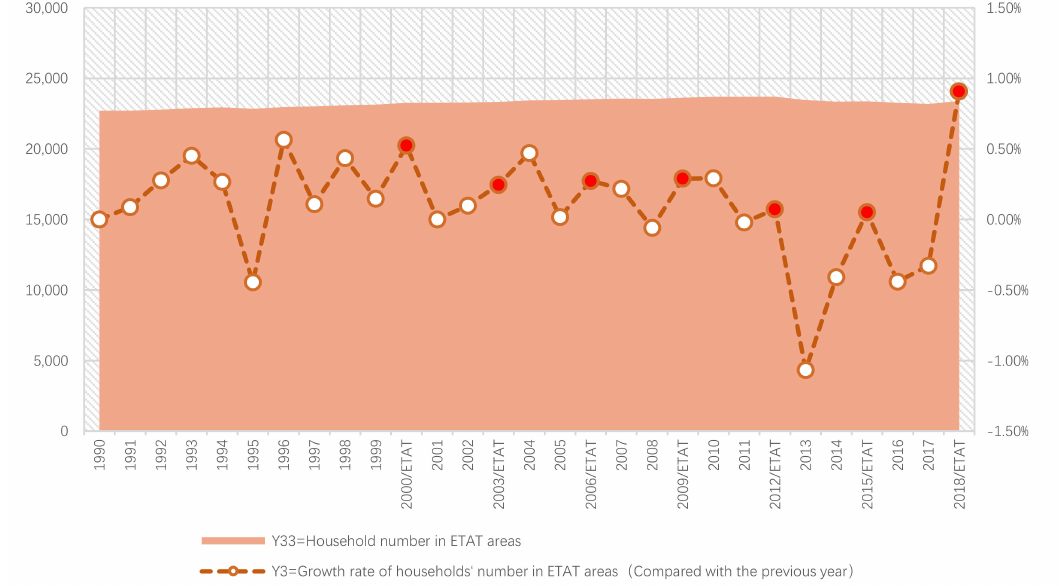
Figure 15. Household number and its growth rate in ETAT areas